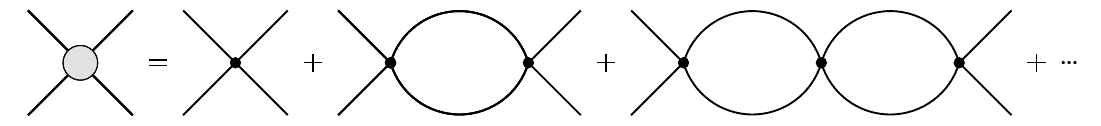
Figure 4 . Diagrams for wino-wino scattering in the Zero-Range Model without electromagnetism. The solid lines are either neutral winos w 0 w 0 or charged winos w + w (cid:0) . The solid lines in each bubble are summed over w 0 w 0 and w + w (cid:0) . The bubble diagrams must be summed to all